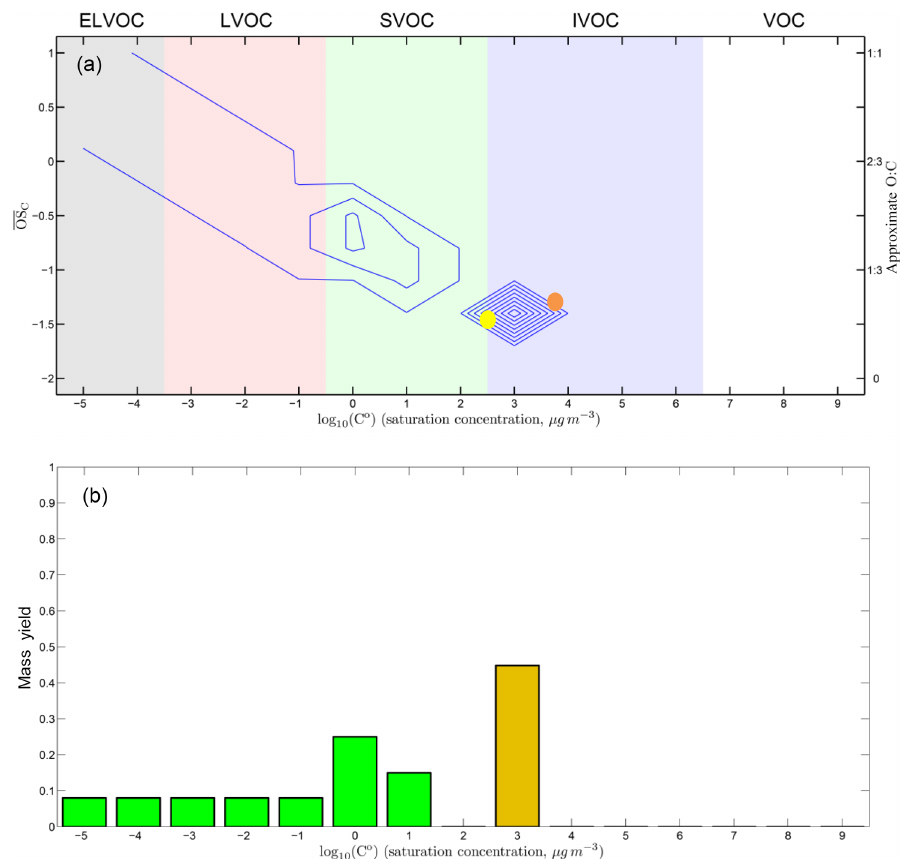
Figure 12. Representation of the oxidation products from PD in the two-dimensional volatility–oxidation space for a mass accommodation coefficient α = 1. We group organics in the broad classes of ELVOCs, LVOCs, SVOCs, or IVOCs. Panel (a) is a 2-D representation. PD is shown as a yellow dot. The blue contours show the oxidation products from PD, with higher values indicating higher yields. Panel (b) is a 1-D consolidation of the 2-D product contours, showing the total mass yields in each volatility bin. The major products spread toward the upper left from PD, with increased oxidation state and decreased volatility. The products near to the upper left corner, in the ELVOC region, may contribute to new-particle formation observed in the CLOUD experiments. They constitute around 15% of the total SOA mass. Some products may undergo fragmentation or functional group change, such as converting an alcohol group to a carbonyl group, as with oxy-pinocamphone, which is shown in